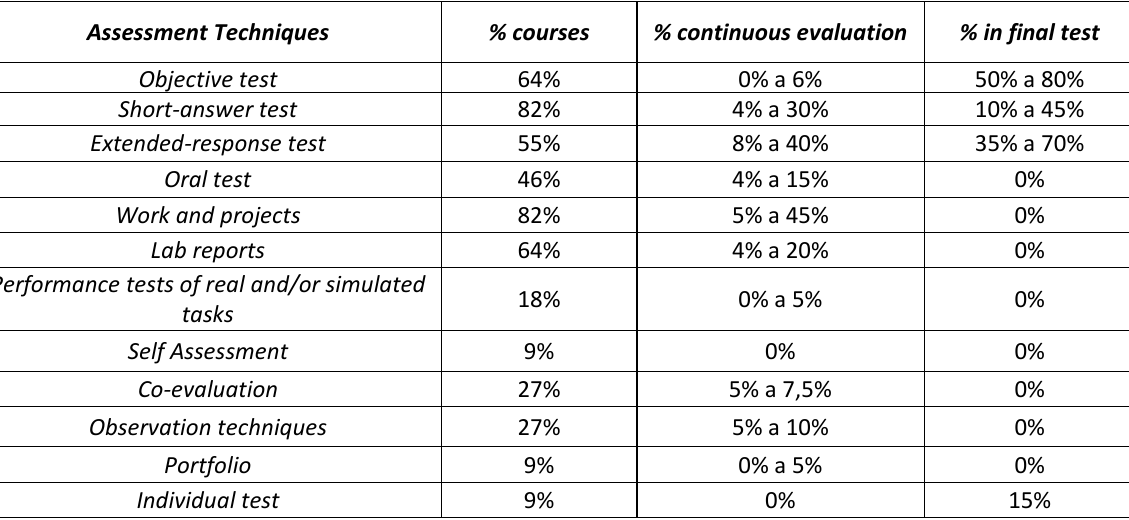
Table 1. Analysis summary of the assessment methods